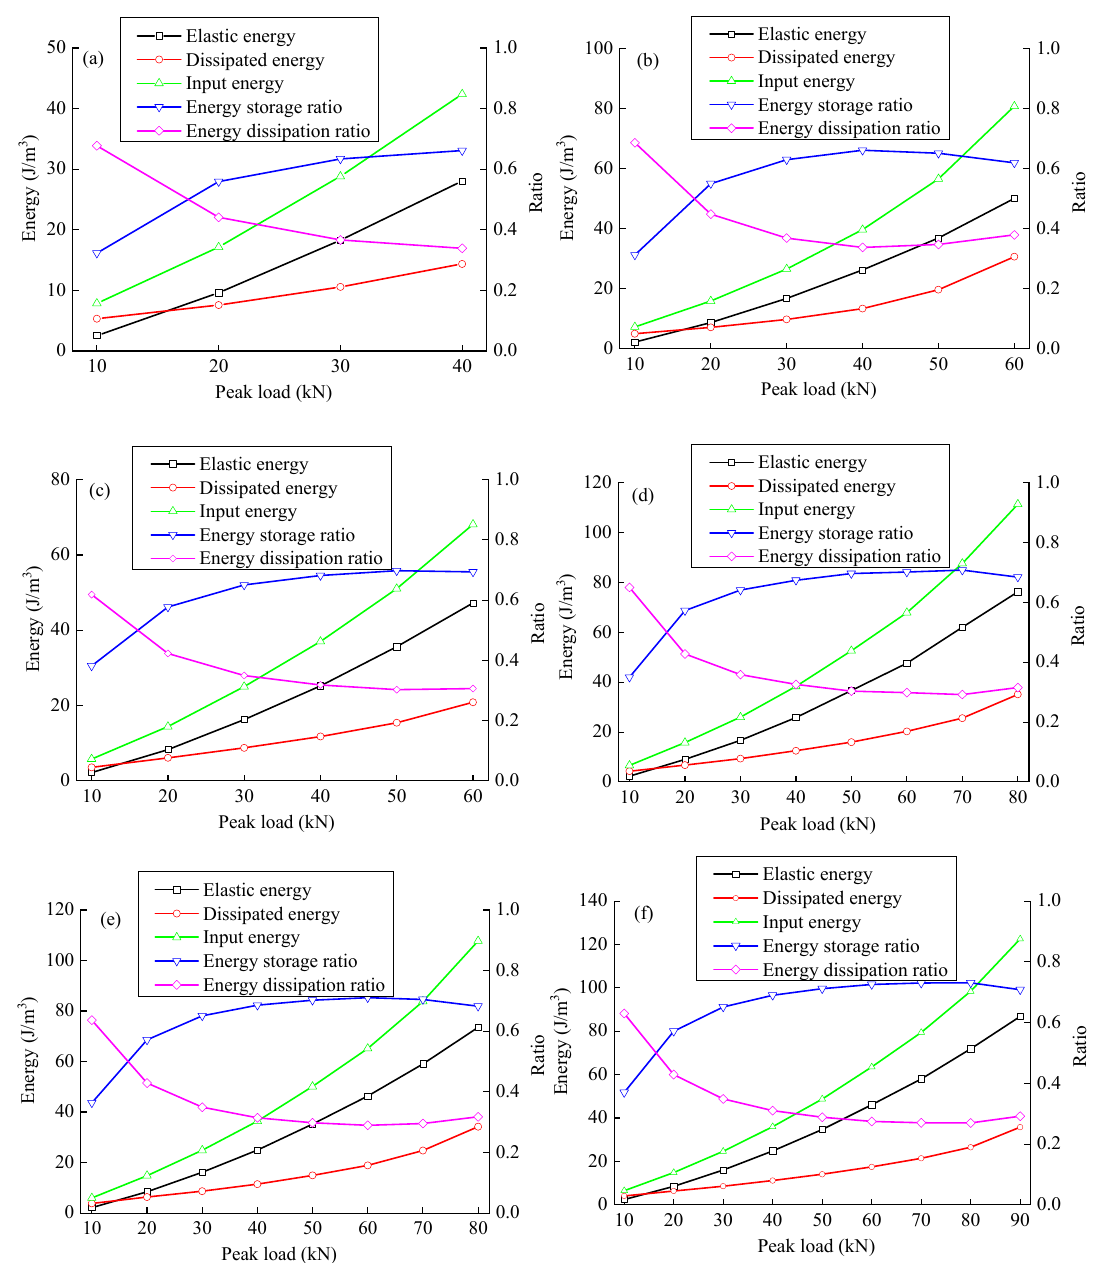
Figure 7. Evolution curves of input energy, elastic energy, dissipated energy, energy storage ratio, and energy dissipation ratio. (( a – f ): X-0°, X-30°, X-45°, X-60°, X-90°, and X-intact, respectively). To study the relationships between dissipated energy, damage energy, and damping energy of rock under cyclic loading, the evolution laws of damping energy, damage energy, damping energy ratio, and damage energy ratio are obtained using the theoretical methods in Section 4.2 and Equations (7), (8) and (10).